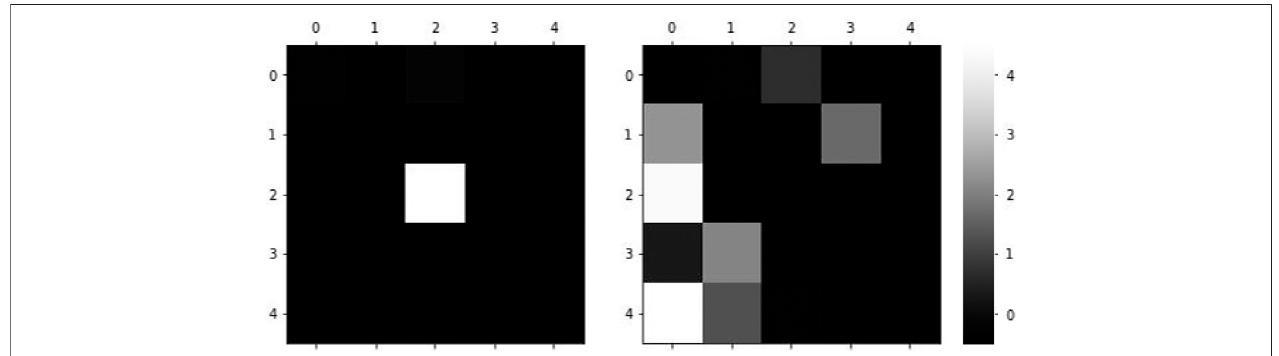
FIGURE 9 | Heat map of the veri fi cation of the confusion matrix of the logistic regression model (the veri fi cation result of the logistic regression confusion matrix is shownintheheatmap.Thecolorinthe fi gurerangesfromblacktowhite,indicatingthattheveri fi cationresultvaluerangesfrom0to5.Thehigherthethermalvalueis,the more accurate the veri fi cation result of the confusion matrix).